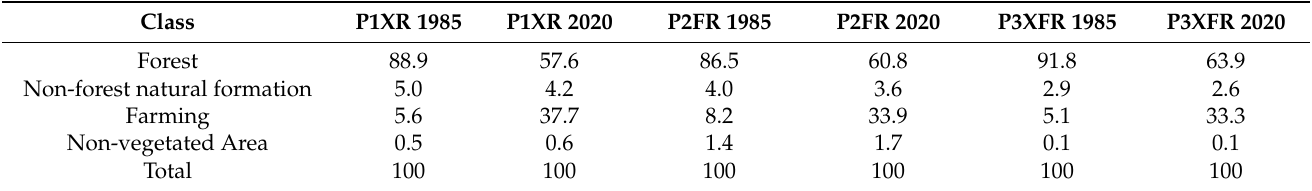
Table 1. Spatial distribution of land use classes and vegetation cover (from 1985 to 2020) in the study area (in%) in the municipality of S ã o F é lix do Xingu, Par á state, Brazil, from the P1XR, P2FR, and P3XFR